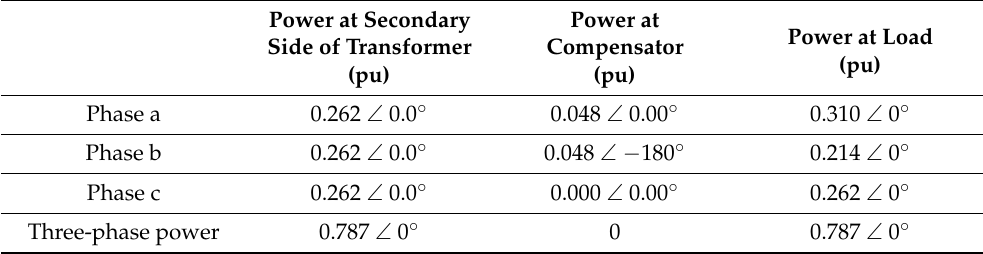
Table 2. Power flow with compensation by the circuit analysis method in Case A.